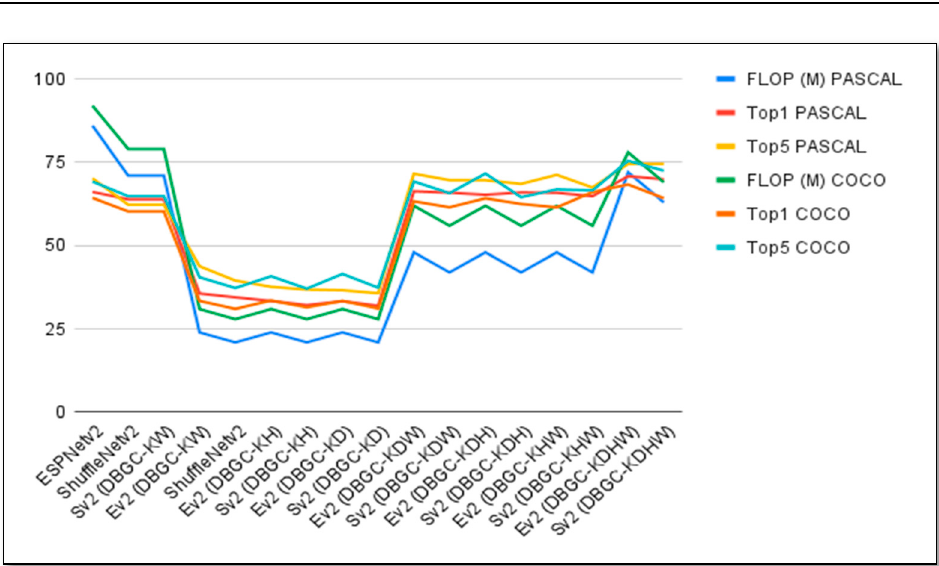
Figure 27. Graph to visualize the performances of unoptimized, semi-optimized, and optimized kernels for ESPNetv2 versus ESPNetV2 (DBGC), and ShuffleNetv2 versus ShuffleNetV2 (DBGC) using the PASCAL and COCO datasets.